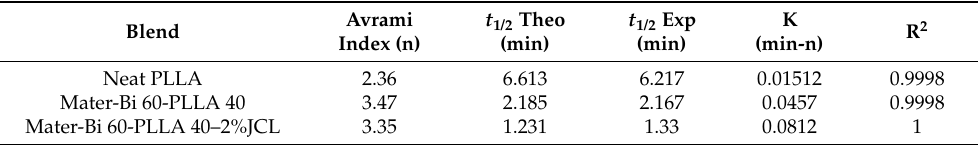
Table 5. Parameters of the Avrami fit obtained from isothermal analysis at 120 ◦ C of 60/40 Mater- Bi/PLLA blend: Avrami exponent (n), predicated half-time crystallization ( t 1/2 Theo), experimental half-time ( t 1/2 exp), overall transformation constant (k), and correlation coefficient (R 2 ). Blend